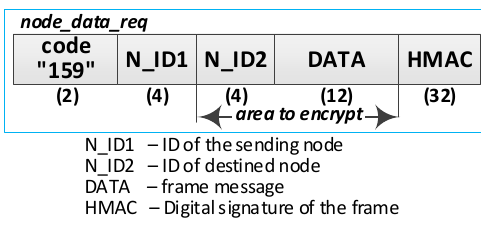
Figure 32. The data frame.